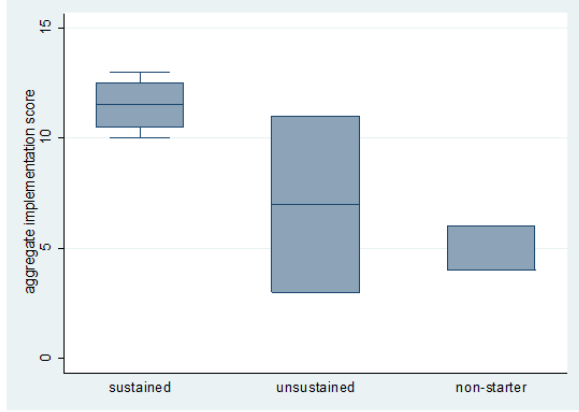
Figure 3. Aggregate implementation scores, by country scale-up type. Box plot with whiskers from minimum to maximum scores for the “sustained success” countries. The whiskers indicate the range of the data and are represented as vertical lines ending in a small horizontal line. The median and the interquartile range (IQR) were used to construct each box. The horizontal bar in the middle is the median score and the height of the box is equal to the IQR, drawn so that it starts at the 25 th percentile (lower quar- tile value) and stops at the 75 th percentile (upper quartile